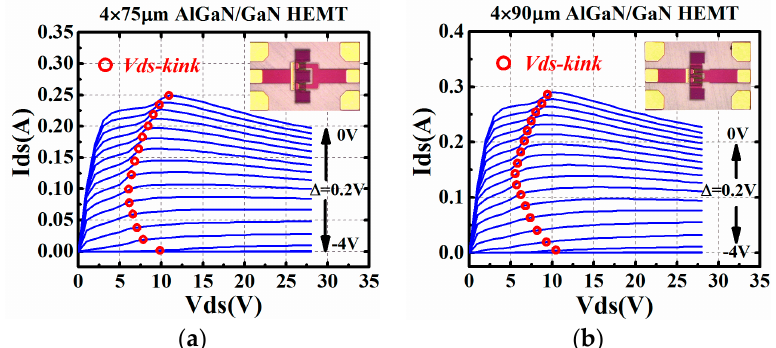
Figure 1. I–V kink effect in 0.25 μ m AlGaN/GaN HEMTs with different gate width: ( a ) 4 × 75 μ m and ( b ) 4 × 90 μ m. ( b ) 4 × 90 µ